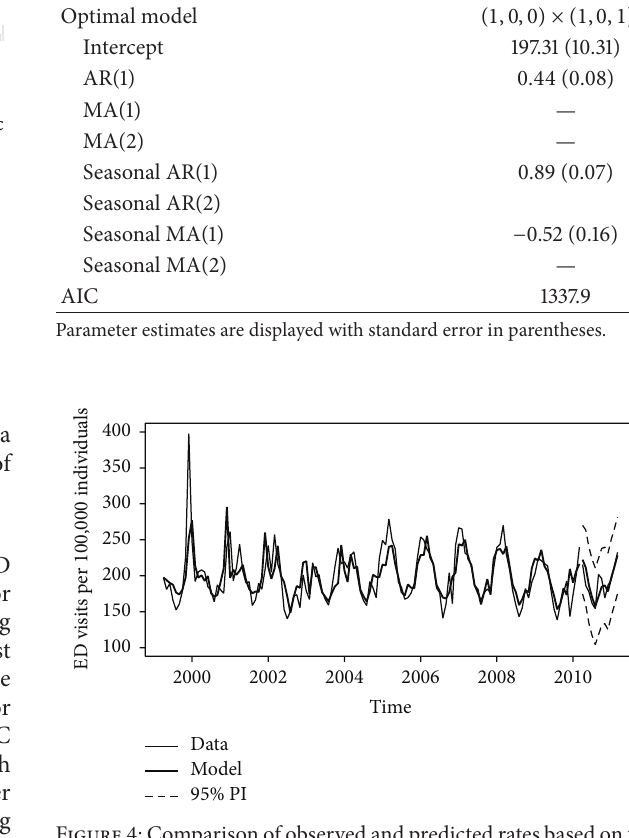
Figure 4: Comparison of observed and predicted rates based on the first 11 years of